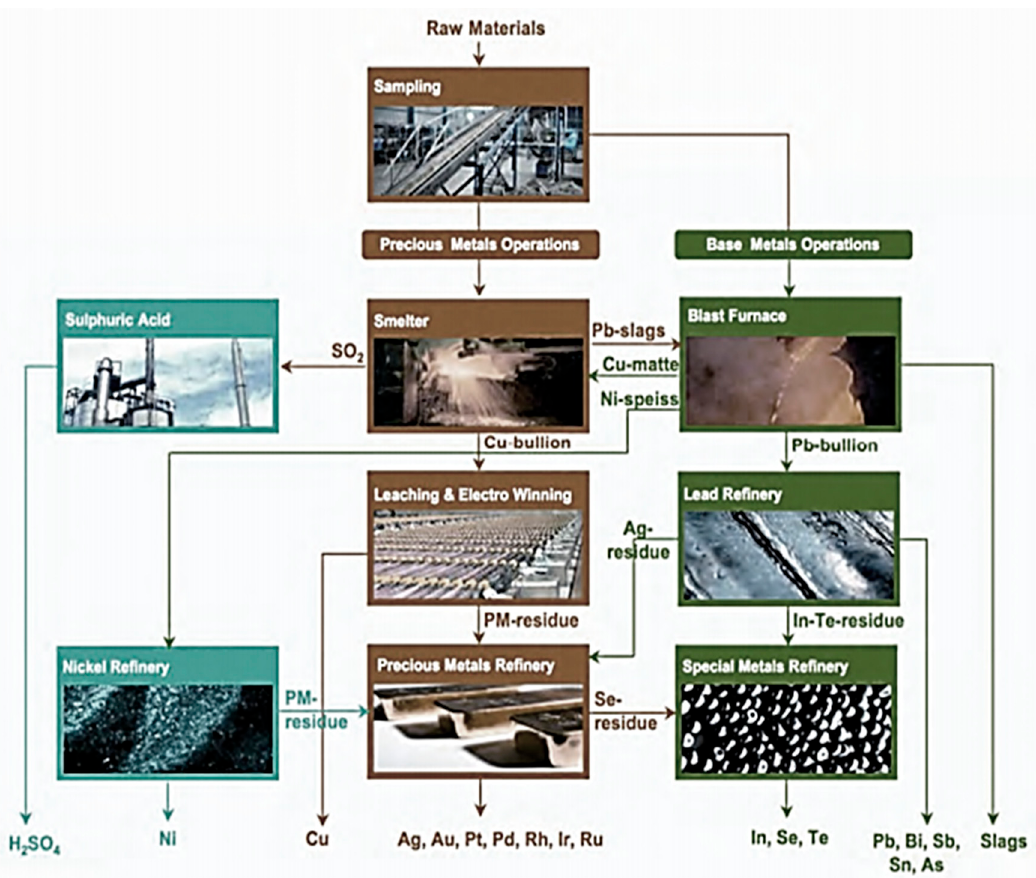
Figure 15. Umicore Integrated smelting refining operations.